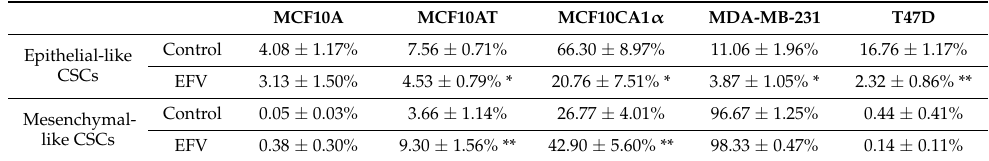
Table 3. Percentage of epithelial-like/mesenchymal-like CSCs in Efavirenz-treated and untreated breast